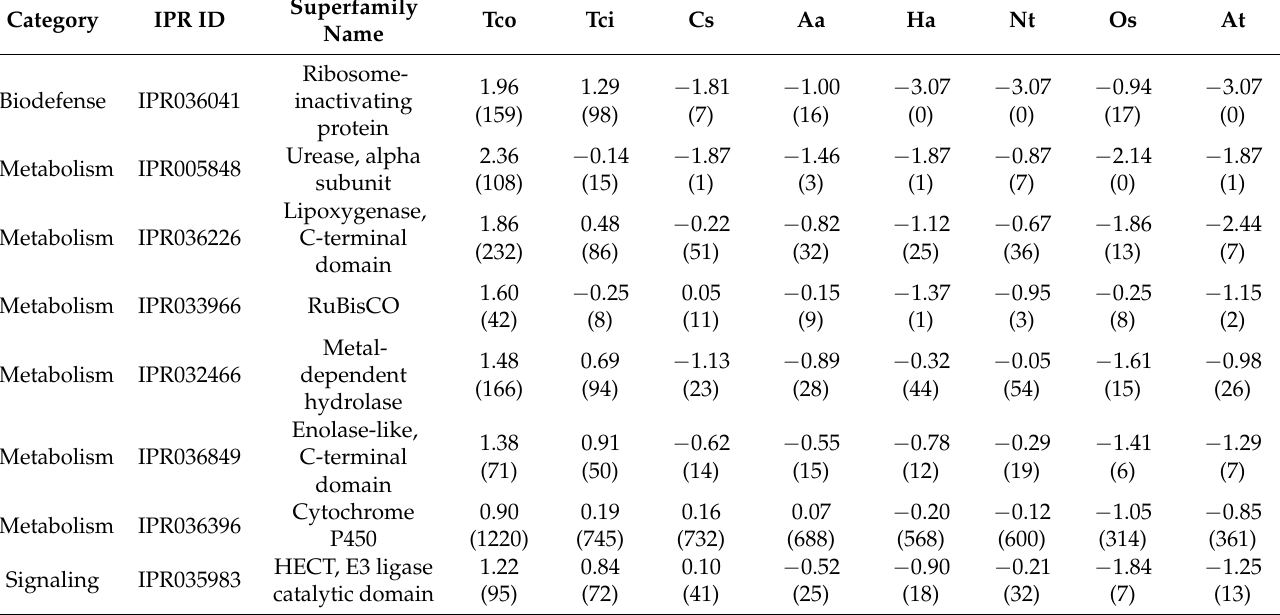
Table 6. Superfamilies with the highest multiplication odds scores in T. coccineum .